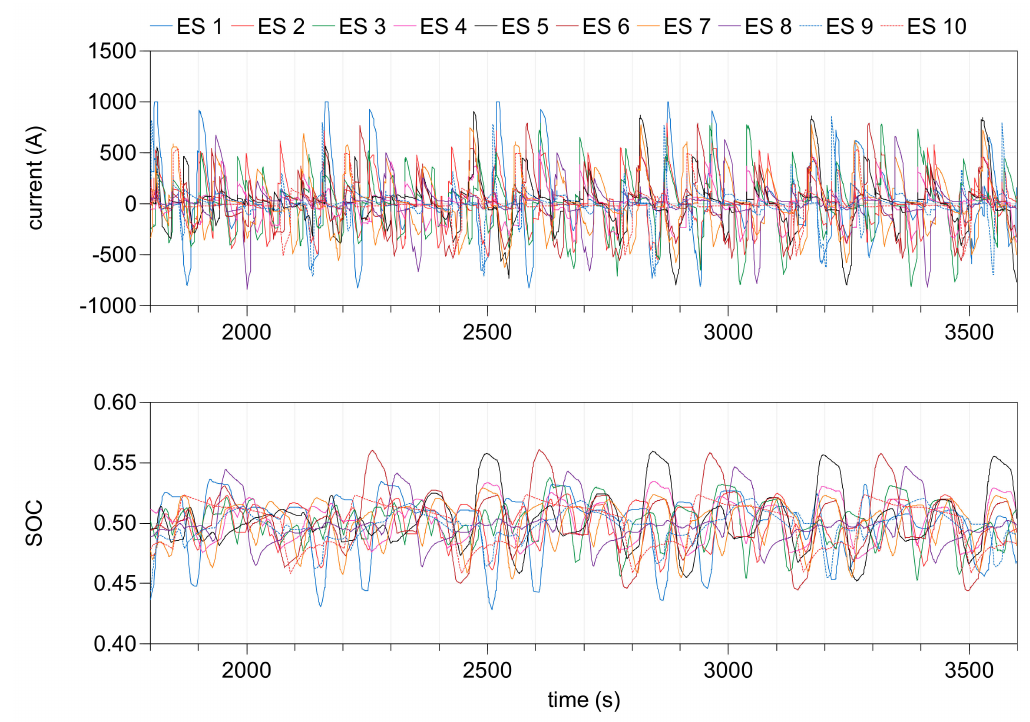
Figure 5. Battery current and SOC when having 10 storage systems installed, rush hour (ten trains